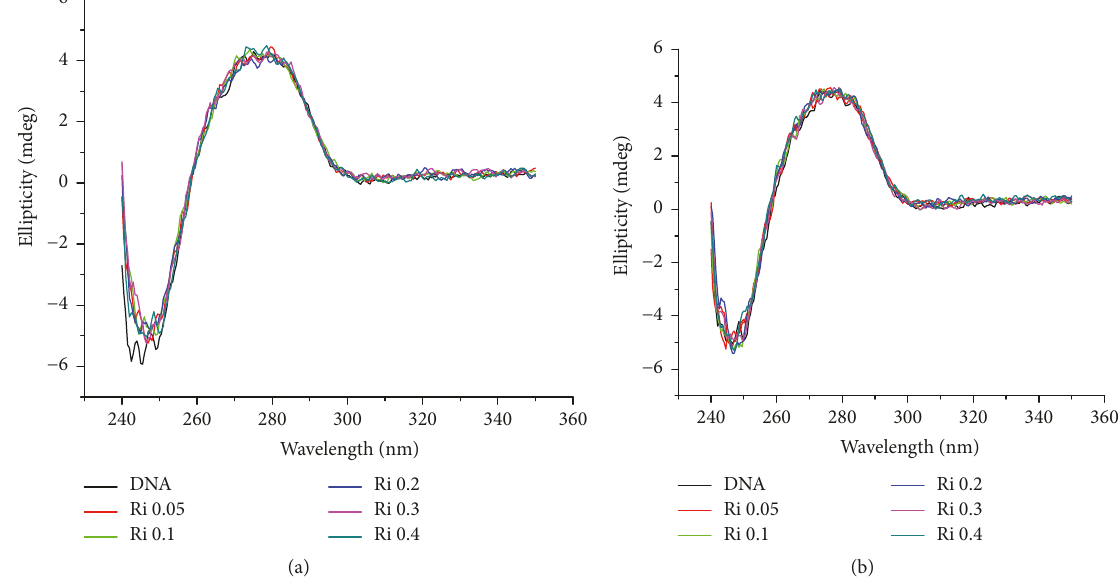
Figure 2: Circular dichroism (CD) spectra of CT-DNA incubated 18 h with complexes 1 (a) and 2 (b) at different [complex]/[DNA] ratios at 37 ∘ C.